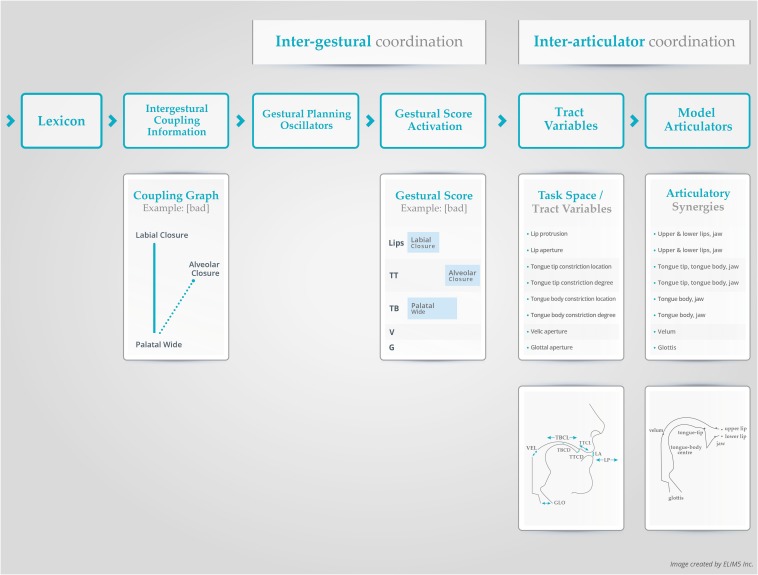
A schematic representation of the AP model with key components (Nam and Saltzman, 2003; Goldstein et al., 2007). TT, tongue tip; TB, tongue body; CD, constriction degree; CL, constriction location; Vel (or V in panel 3), Velum; GLO (or G in panel 3), glottis; LA, lip aperture; LP, lip protrusion (see text for more details).